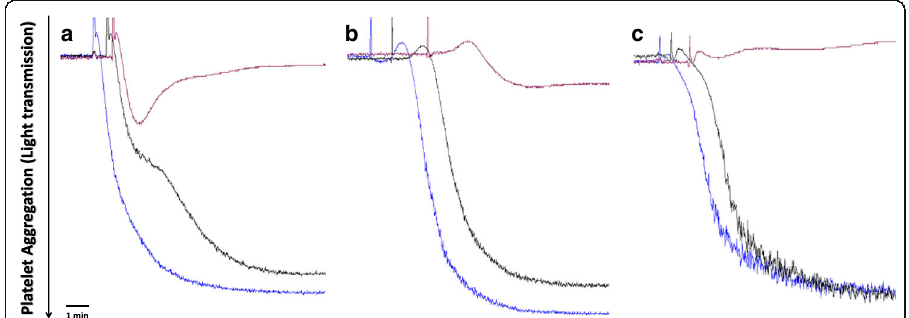
Fig. 2 Norpurpureine is a non-selective inhibitor of human platelet aggregation. Typical traces of platelet aggregation responses monitored by changes in the light transmission signal over time are shown. Platelets were incubated with the vehicle (0.25% DMSO, blue), 250 μ M purpureine (black) or 250 μ M norpurpureine (red) for 10 min before their stimulation with 10 μ M ADP ( a ), 1 μ g/ml collagen ( b ) (in PRP) or 0.075 U/ml